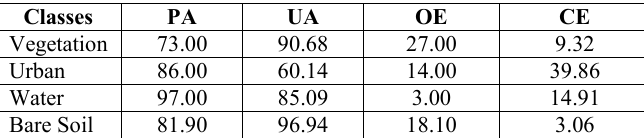
Table 3 Statistics derived through Minimum distance classification